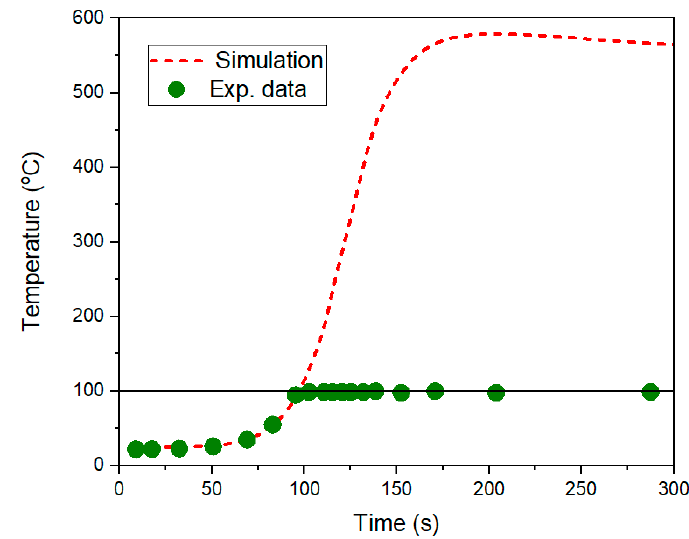
Figure 1. Comparison of experimental data (green circles) from the aniline polymerization at high (2 M) concentration of AniHCl and APS with a simulation based on the kinetic model (dashed red line).